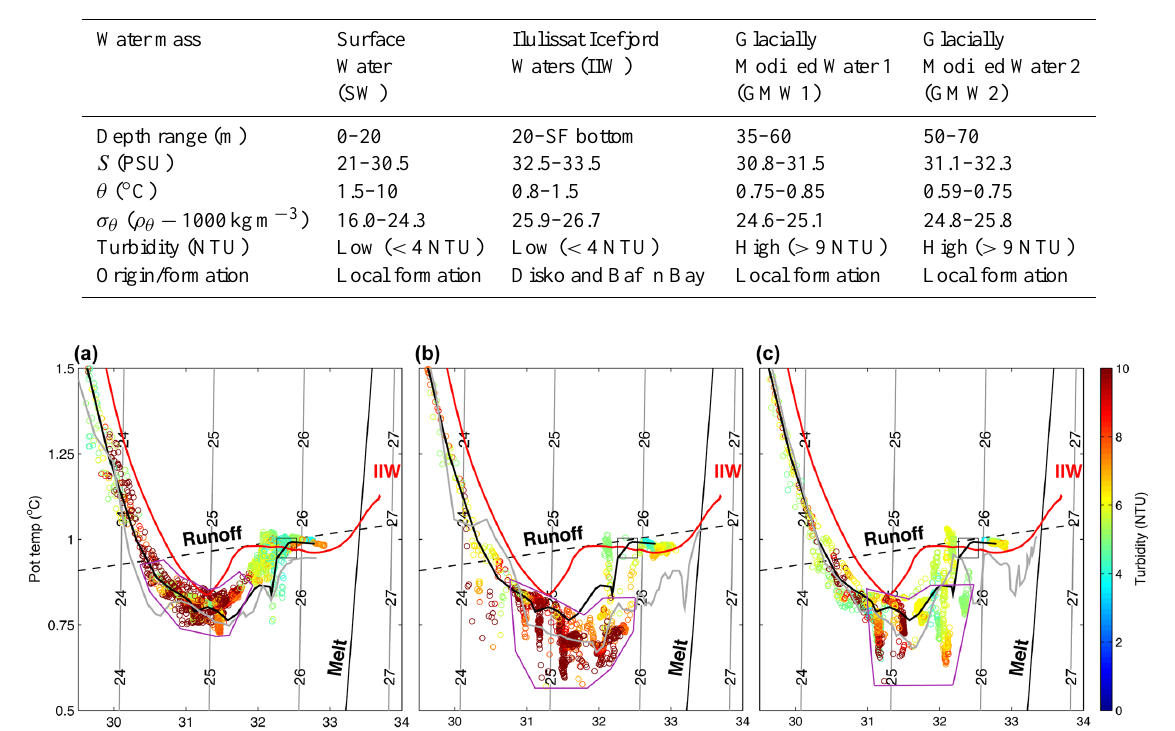
Table 2. Water mass properties in Sarqardleq Fjord.